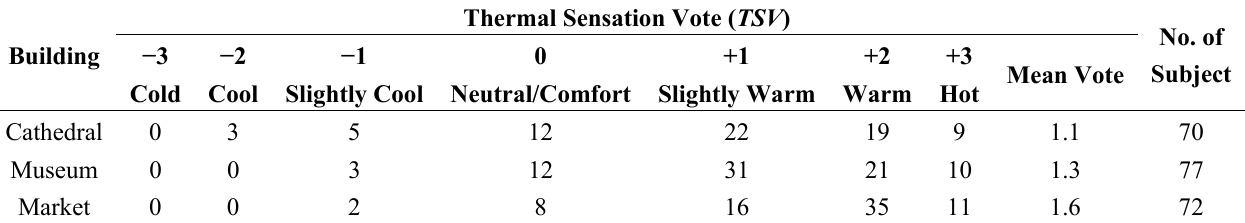
Table 3. Climatic parameters and the distribution of TSV in the three buildings. Building